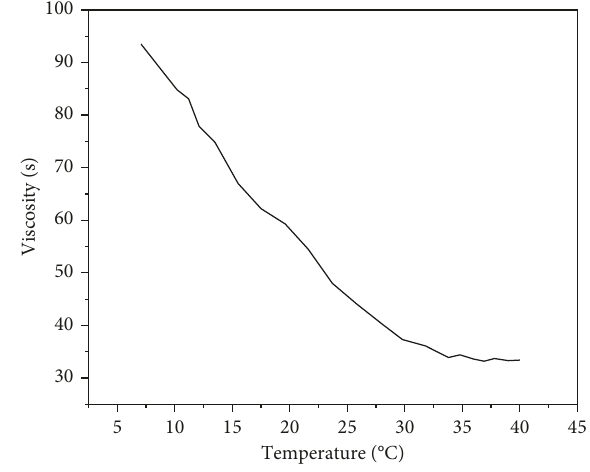
Figure 2: Viscosity-temperature curve.